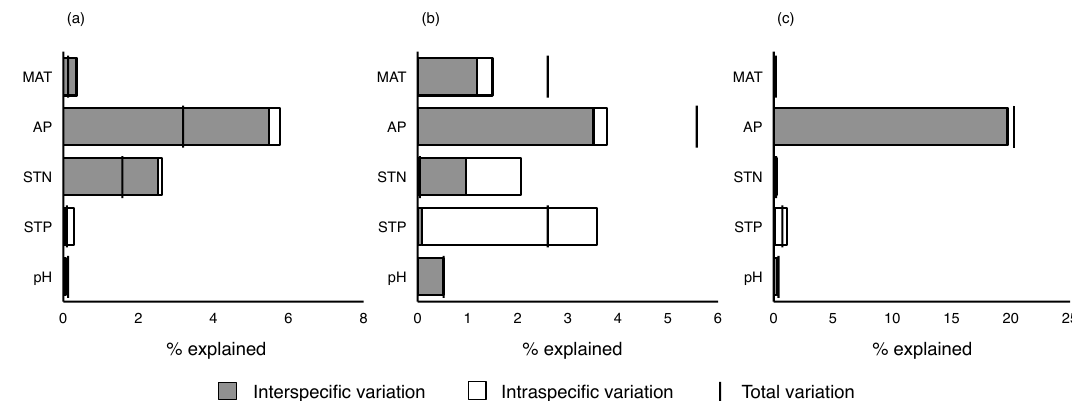
Figure 4. Decomposition of total variation in leaf N (a) , P (b) and N:P (c) of shrubs in shrubland of northern China. Grey shading corre- sponds to interspecific variation, and open part corresponds to intraspecific variation. Black bar denotes total variation. The space between the top of the column and the black bar corresponds to the covariance between interspecific and intraspecific